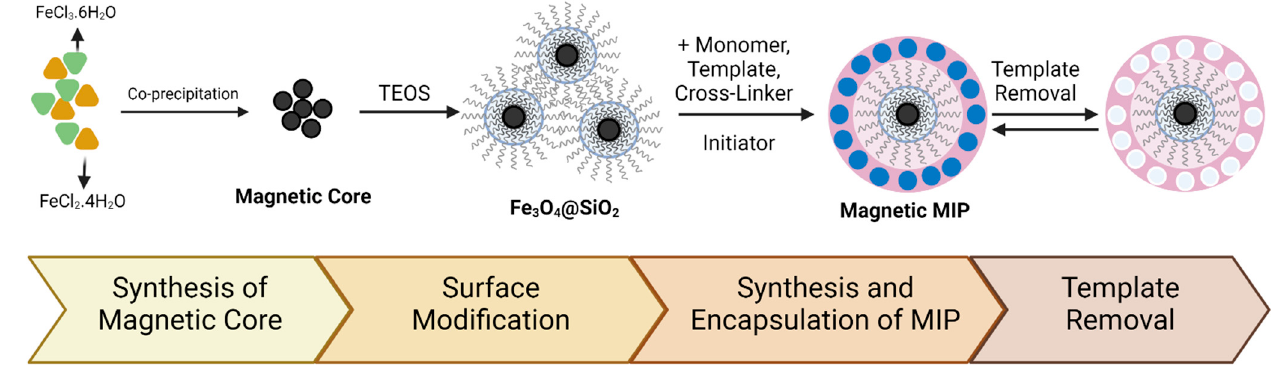
Figure 1. Schematic of MMIP synthesis.